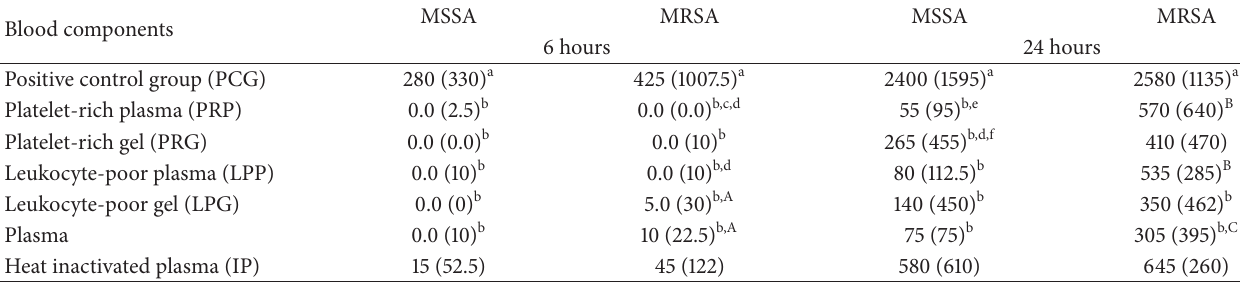
Table 1: Median (interquartile ranges (IR)) for both methicillin-sensitive Staphylococcus aureus (MSSA) and methicillin-resistant S. aureus (MRSA) (CFU/mL × 10 8 ) (1: 100 × 10 3 dilution) for every blood component over time.